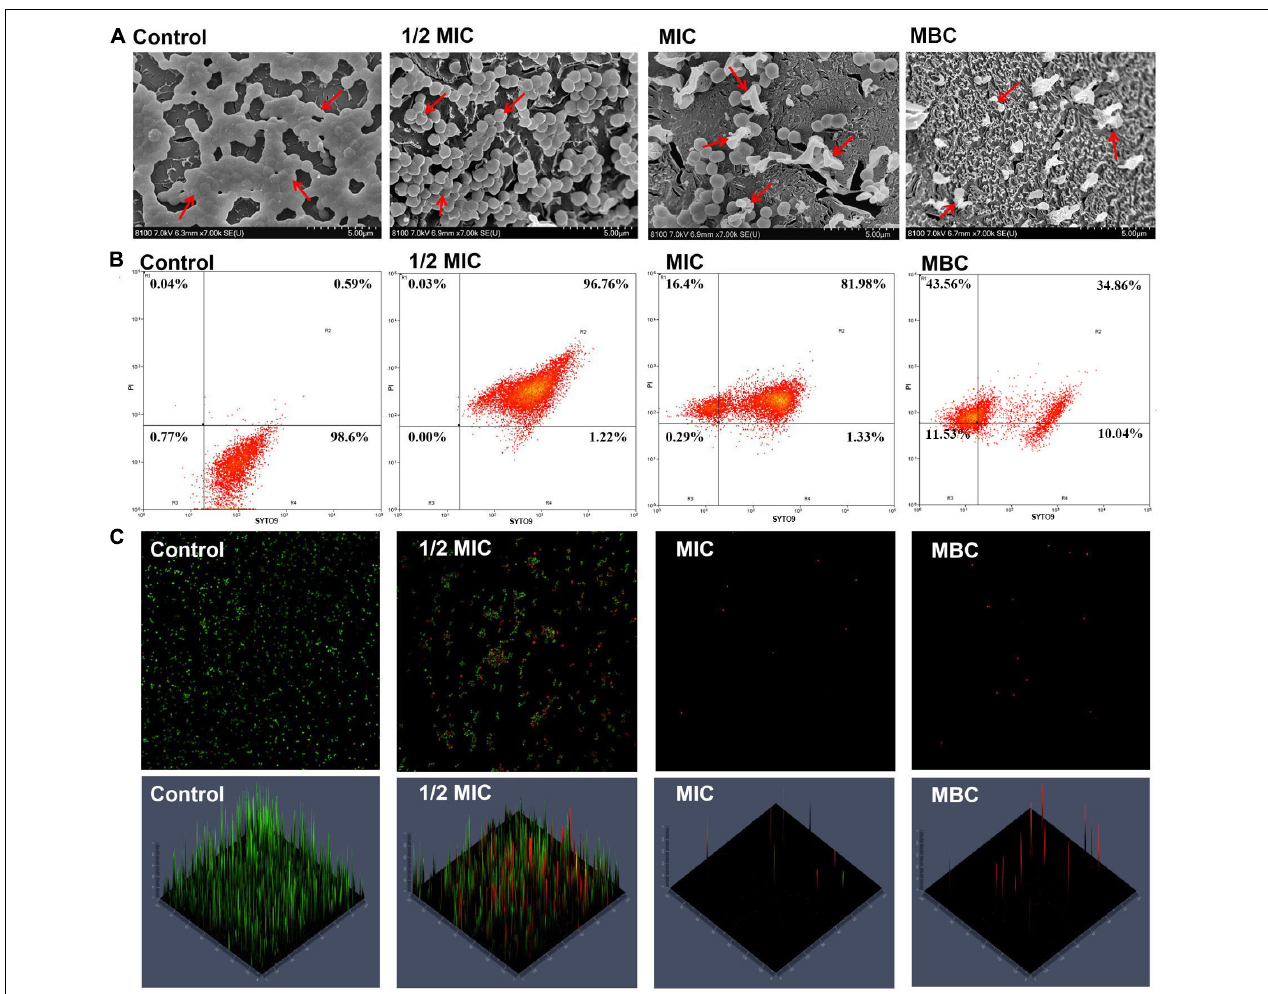
FIGURE 3 | Cryo-SEM images of S. aureus after treatment with the OEO for 8 h at different concentrations of 1/2 MIC, MIC, and MBC (A) . Fluorescence dot images of S. aureus cells exposed to the OEO at 0, 1/2 MIC, MIC, and MBC, as analyzed by FCM (B) . CLSM showed the S. aureus viability treated with different concentrations of OEO. The cells stained with SYTO9 are labeled green, while the cells stained with PI are labeled red (C)